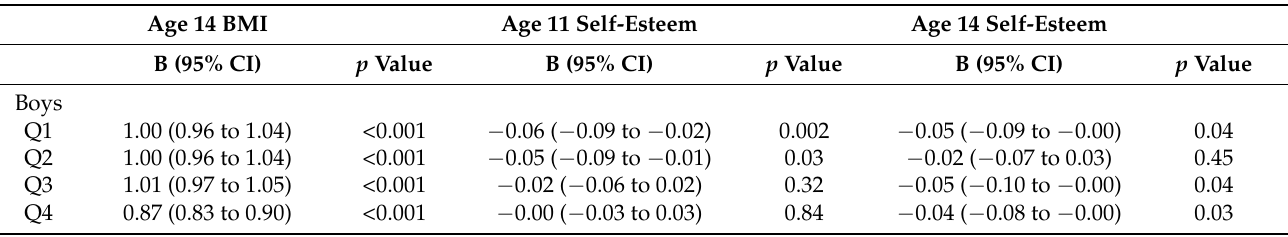
Table 3. Regression analyses showing age 11 BMI as a predictor of age 14 BMI, age 11 self-esteem scores and age 14 self-esteem scores for each sport participation quartile by gender. Adjusted regression coefficients and 95% confidence